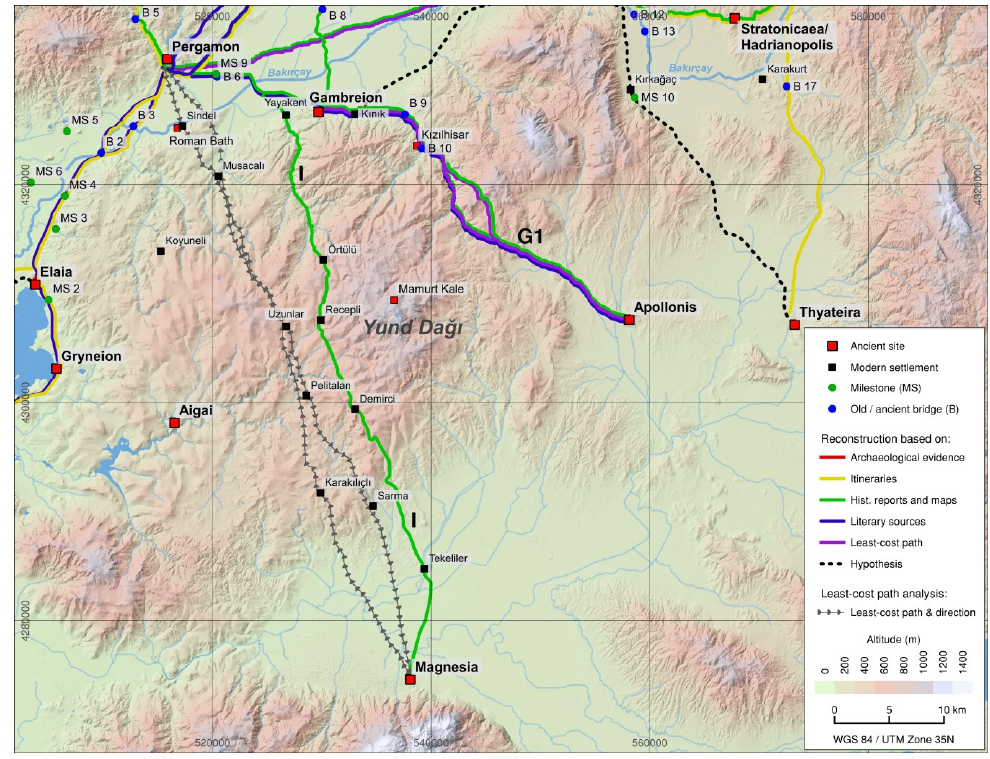
Figure 20. Calculated least-cost paths and reconstructed route between Magnesia and Pergamon. Land 2020 , 9 , x FOR PEER REVIEW